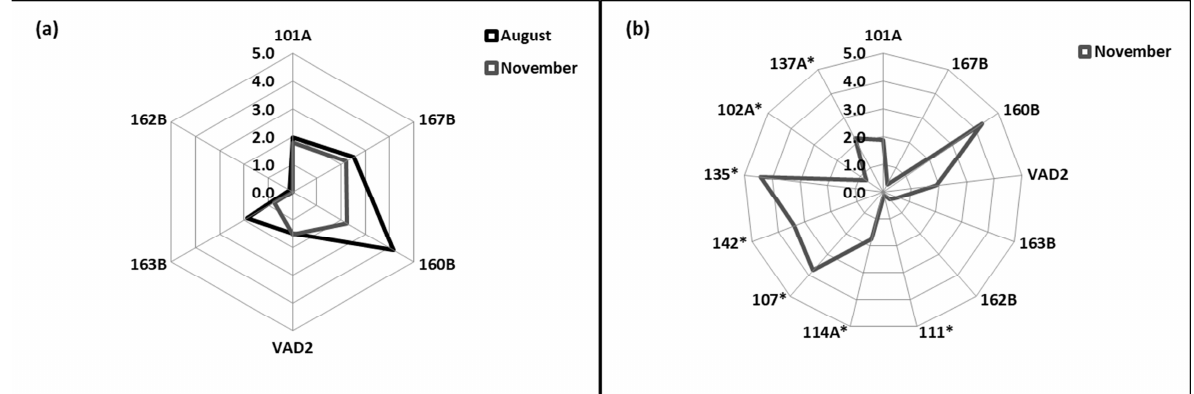
Figure 5. Integrated biomarker response index (IBR) in the amphipod M. affinis collected from ( a ) coastal, year 2020 and ( b ) coastal and deep-water stations (marked *), year 2021 from the GoR.